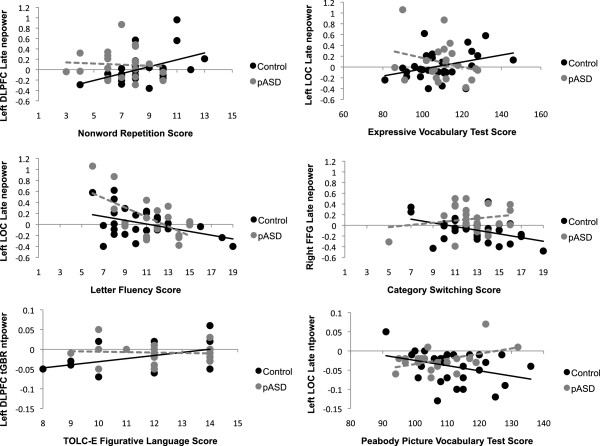
Gamma regression results. Representative plots of the regression results assessing the relationships between gamma-band activity and language measure scores. nepower: normalized evoked power; ntpower: normalized total power; tGBR: transient gamma band response (30–150 ms post-stimulus), late: late gamma band response (200–800 ms post-stimulus); DLPFC: dorsolateral prefrontal cortex; LOC: lateral occipital cortex; FFG: fusiform gyrus; TOLC-E: Test of Language Competence-Expanded Edition.